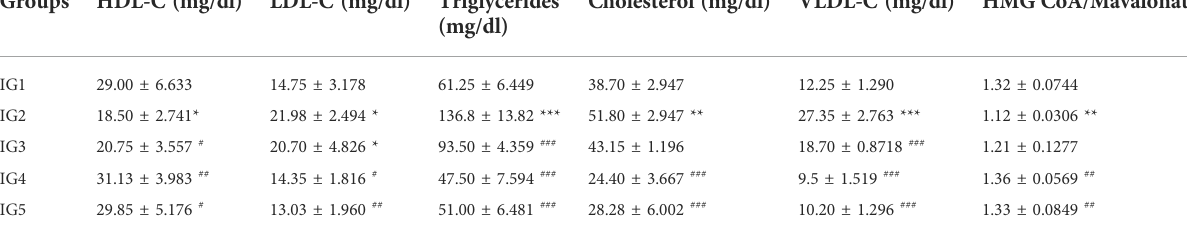
TABLE 3 Effect of ISO and GC pretreatment on the lipid pro fi le. Groups